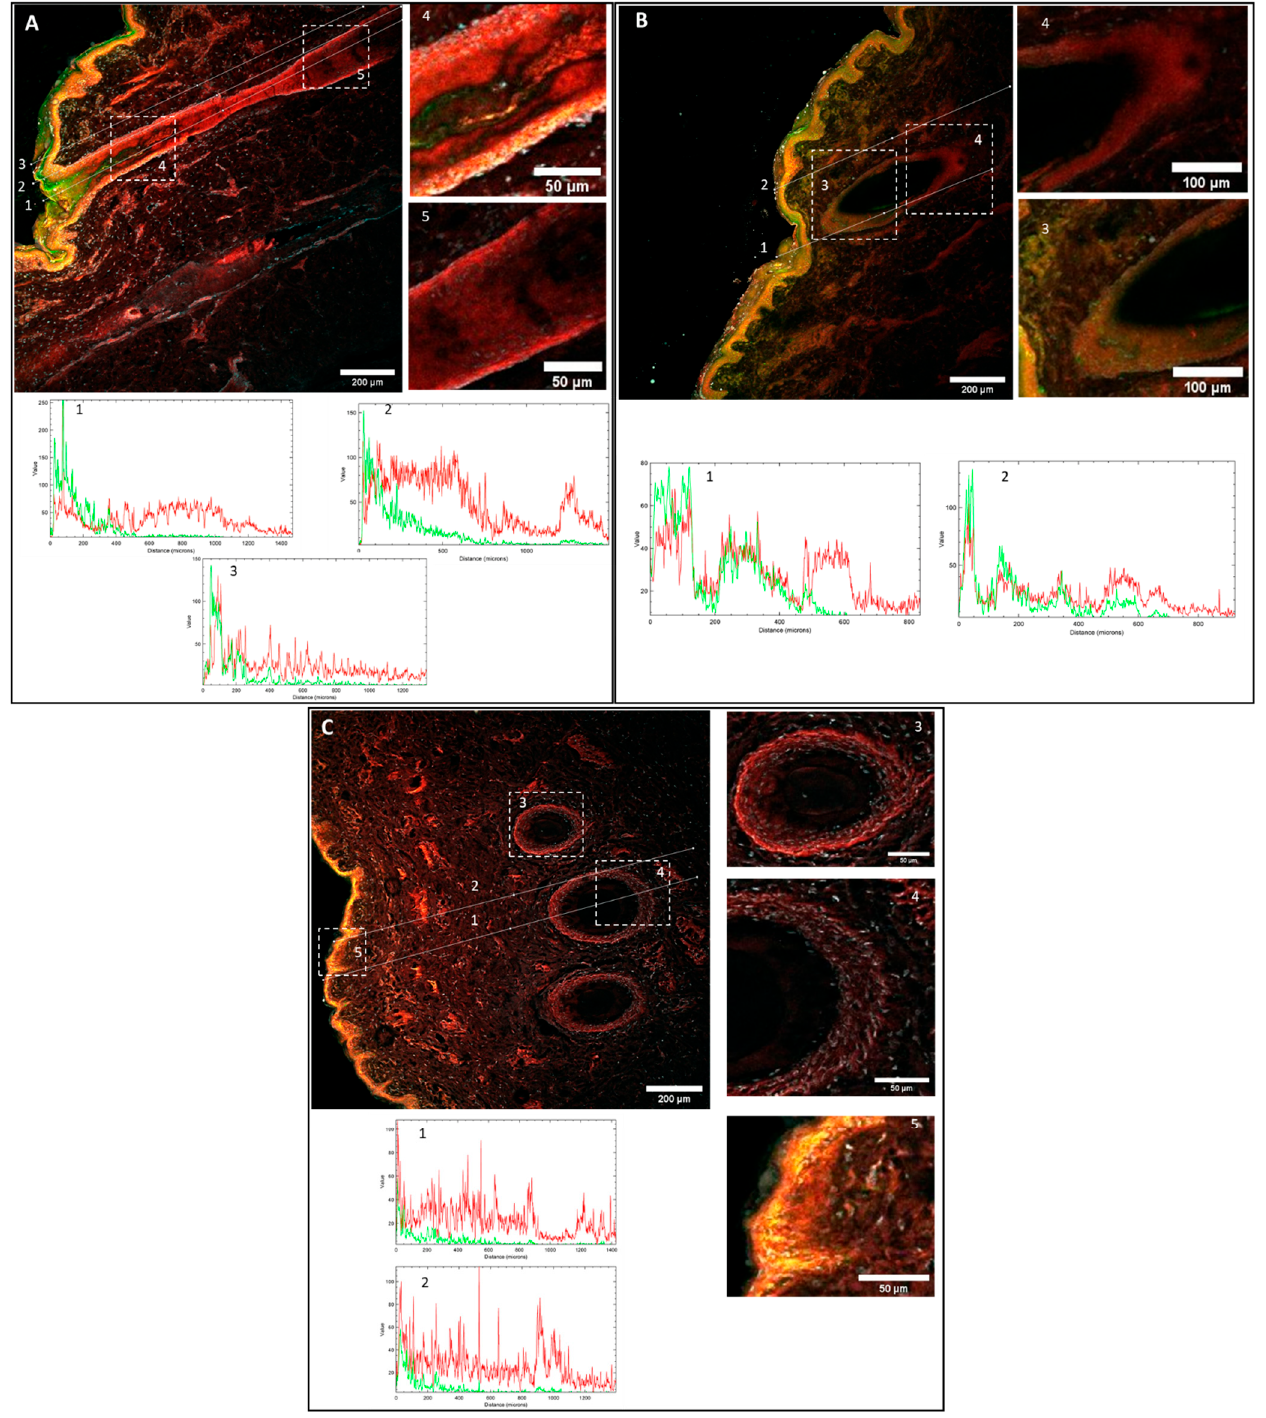
Figure 5. Confocal Microscopy Fluorescence images and plot intensity profiles of pig skin cross-sections. Green color corresponds to C6 and red to LRB fluorescence. Yellow color corresponds to the overlap of C6 and LRB: ( A , B ) C6-loaded LRB-labelled LPNCs. ( C ) Free C6 and LRB control solution. Lines numbered 1-3 in Figure 5A; 1-2 in Figure 5B and 1-2 in Figure 5C correspond to Multichannel intensity plot profiles as function of the depth (µm). Dashed squares numbered 4-5 in Figure 5A, 3-4 in Figure 5B and 3-4 in Figure 5C correspond to zoomed in regions. The images were captured using 10x magnification. Figure 5A,B show the biodistribution patterns of the C6 and LRB fluorophores vehiculated in LPNCs (C6-LRB-LPNCs).